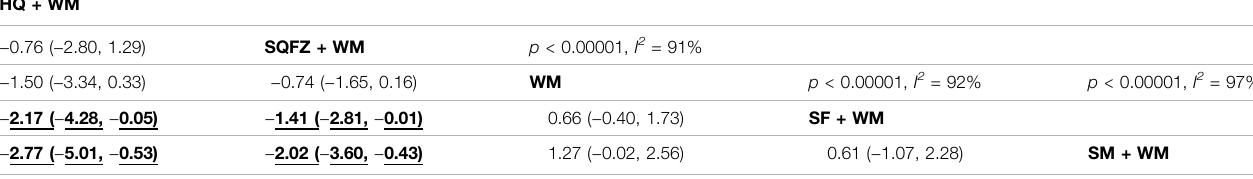
TABLE 9 | SMDs with 95% CIs of CD8 + . Signi fi cant effects are printed in bold. HQ + WM − 0.76 ( − 2.80, 1.29) SQFZ + WM